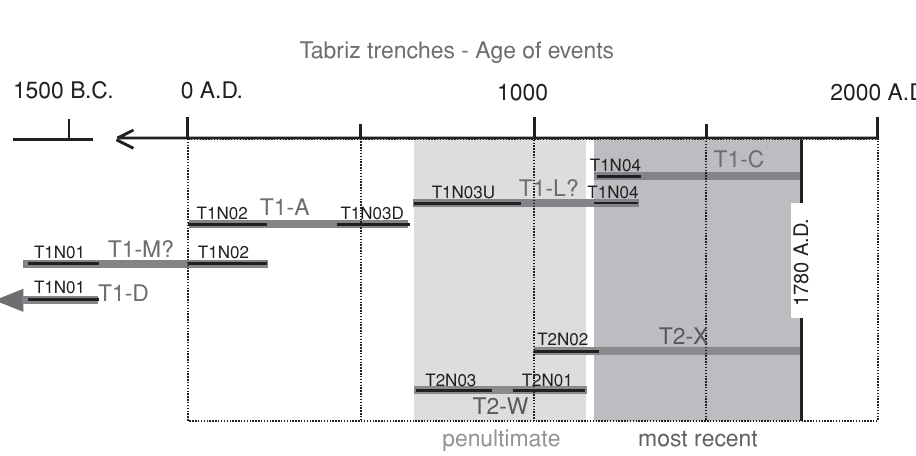
Fig. 9. Attempt of correlation of paleoearthquakes between the two trenches. Black bars are the age ranges of the samples used to constrain the age of occurrence of paleoearthquakes which are reported as thick gray bars. Sample names and event names are shown too. Gray boxes show the correlated age of the most recent and penul- timate events. On the basis of historical considerations we assume the most recent earthquake be the 1780